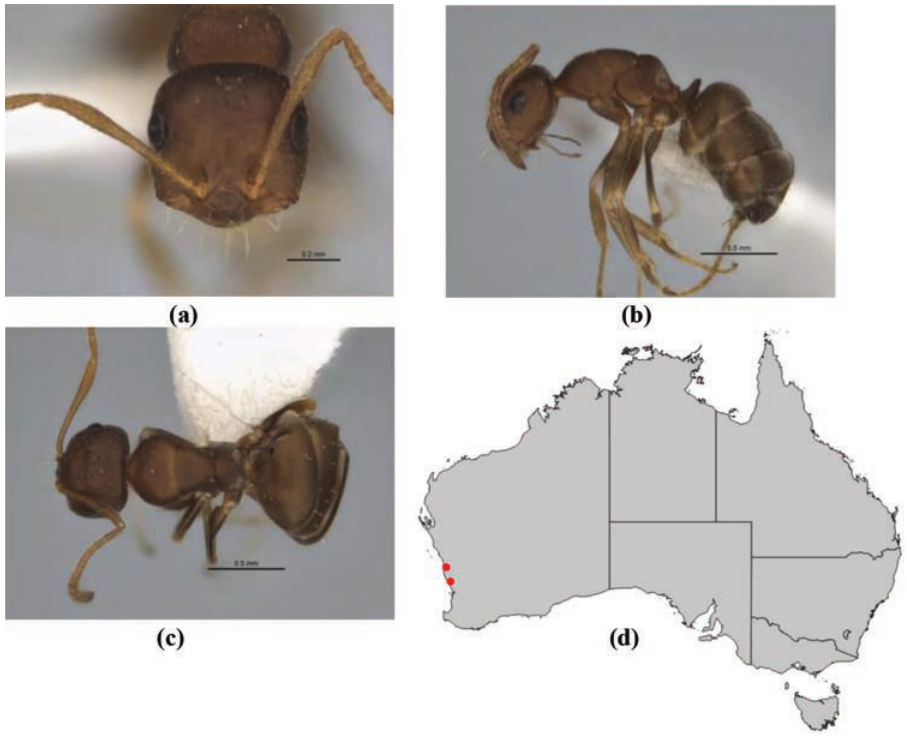
Figure 38. Melophorus latinotus sp. n.: minor worker holotype (JDM32-002004) frons ( a ), profile ( b ) and dorsum ( c ); distribution map for the species ( d ). Low resolution scale bars: 0.5 mm ( b, c ); 0.2 mm ( a ). dibles triangular, weakly incurved; third mandibular tooth distinctly shorter than apical tooth and teeth numbers two and four; masticatory margin of mandibles approximately vertical or weakly oblique. Mesosoma . Integument of pronotum, mesonotum and meso- pleuron matt or with weak sheen and microreticulate throughout; anterior mesosoma in profile rounded anteriad, thereafter pronotum and whole of mesonotum flattened and on a higher plane than propodeum; appearance of erect pronotal setae short, (i.e., long- est erect setae shorter than length of eye) and unmodified; in profile, metanotal groove a narrow but deep slit; propodeum matt or with a weak sheen and microreticulate; propo- deum angulate, propodeal angle blunt; length ratio of propodeal dorsum to its declivity between 1:1 and 1:2; erect propodeal setae always absent; appressed propodeal setulae short, separated by more than own length and inconspicuous; propodeal spiracle situated on or beside declivitous face of propodeum, and longer (length ≥ 0.50 × height of propo- deum). Petiole . In profile, petiolar node squamiform; in full-face view, shape of petiolar node uniformly rounded; node matt with indistinct microsculpture. Gaster . Gaster matt with faint, indistinct microsculpture; pilosity of first gastral tergite consisting of well- spaced, long, whitish, appressed setae with erect setae (present in at least some workers) confined to margin of the sclerite. General characters . Colour dull